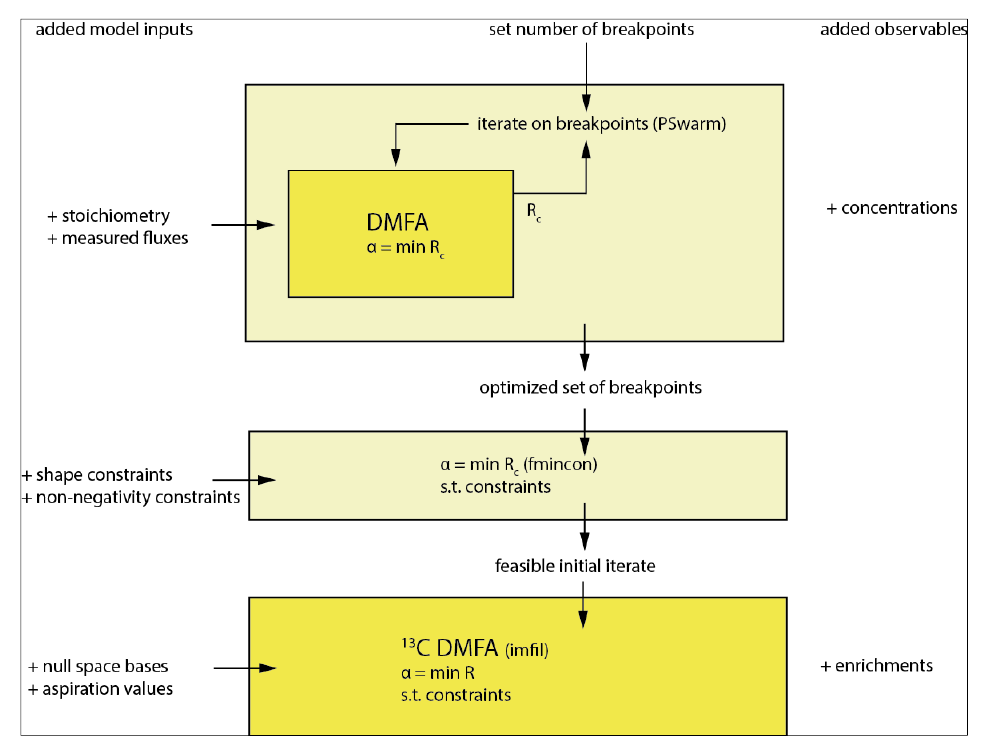
Figure 5. Overall workflow of the method with breakpoint selection as the first step followed by the main optimization and used optimizers in parentheses. The model inputs are successively expanded as described on the left columns. The first two steps only use the concentration observables, whereas the final step additionally incorporates the enrichment observables from the 13 C